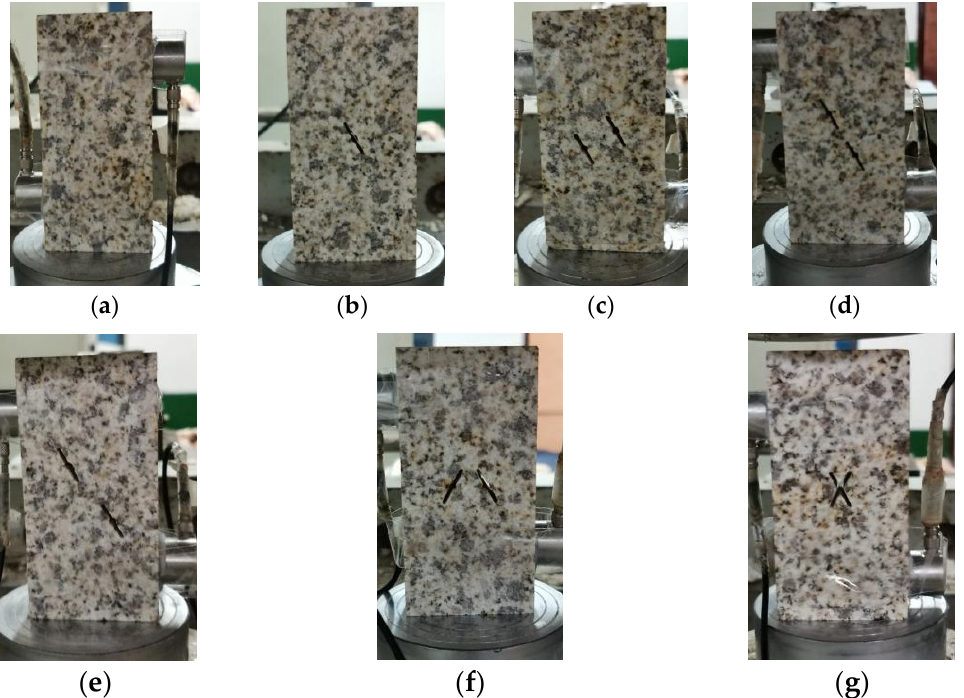
Figure 5. The rock testing machine. ( a ) The intact rock sample; ( b ) rock sample with a single crack; ( c ) rock sample with parallel double cracks; ( d ) rock sample with collinear double cracks; ( e ) rock sample with intermittent double cracks; ( f ) rock sample with conjugate double cracks; ( g ) rock sam- ple with cross double cracks.